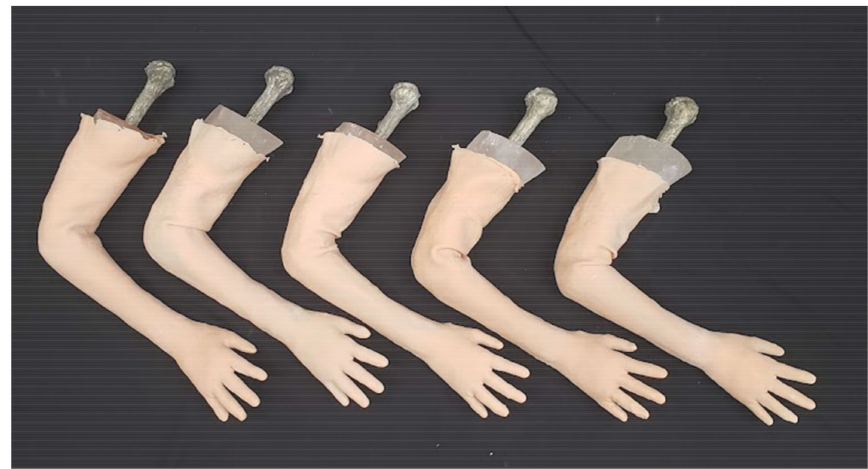
Figure 7. Photograph showing the replicability of full-arm phantoms, with slight variations seen in flesh and skin truncation along the humerus.